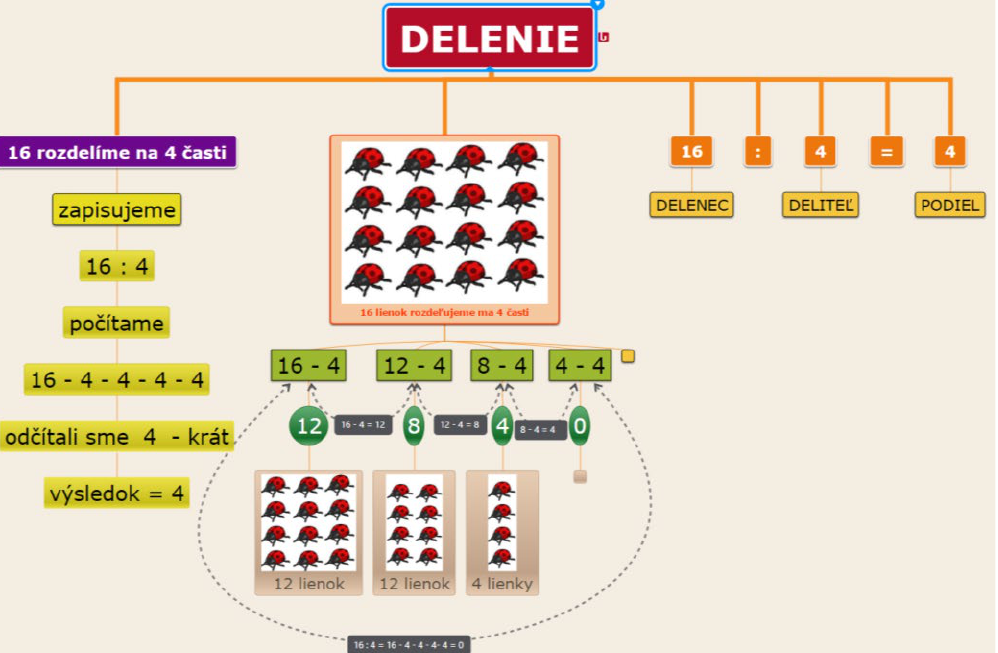
Figure 1. Concept map - drawing principle of division. Legend: Delenie - Division; 16 rozdelíme na